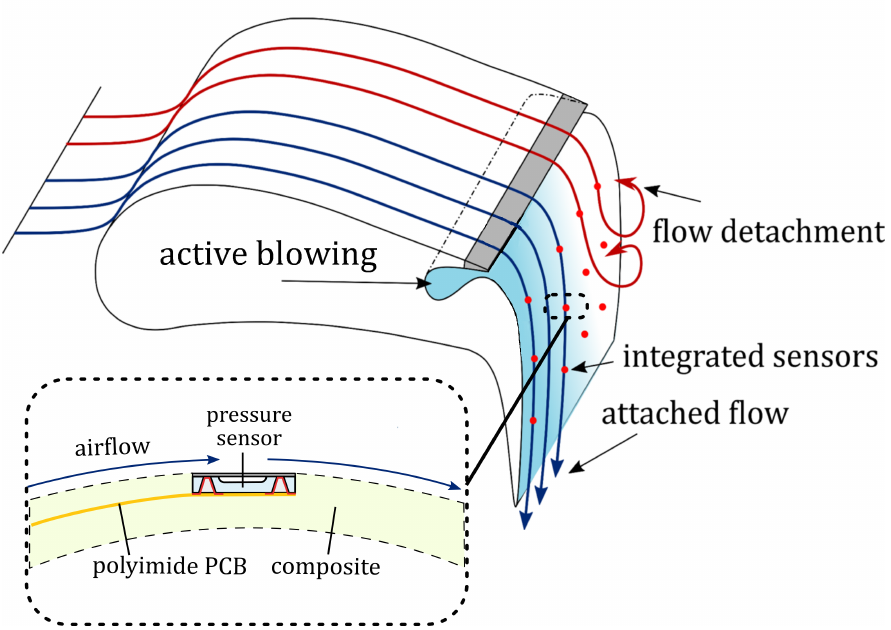
Figure 1. Schematic illustration of an actively controlled high-lift system, utilizing structure- integrated pressure sensors and active blowing (blue) which leads to an attached flow due to the Coanda effect. [2]. The magnified cross-section illustrates the stepless sensor integration into the the Coanda